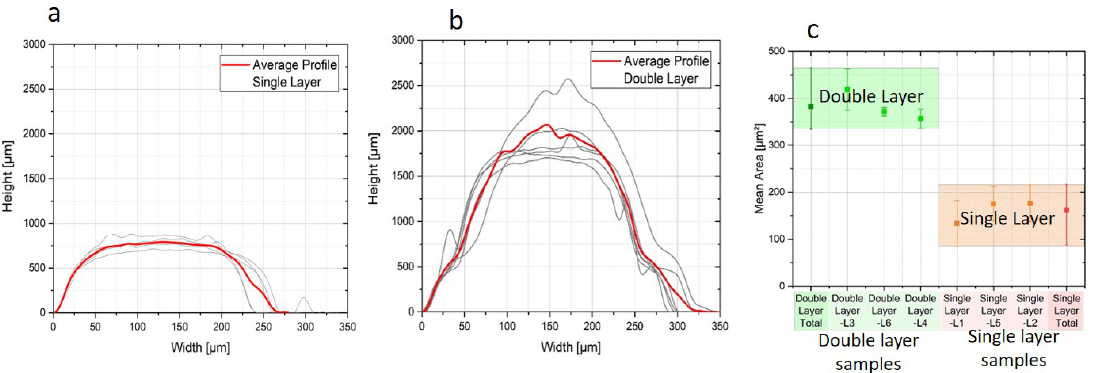
Figure 4. Surface profiles of the single-layer ( a ) and double-layer Ag tracks ( b ). The calculated areas under the profiles are compared in ( c ).